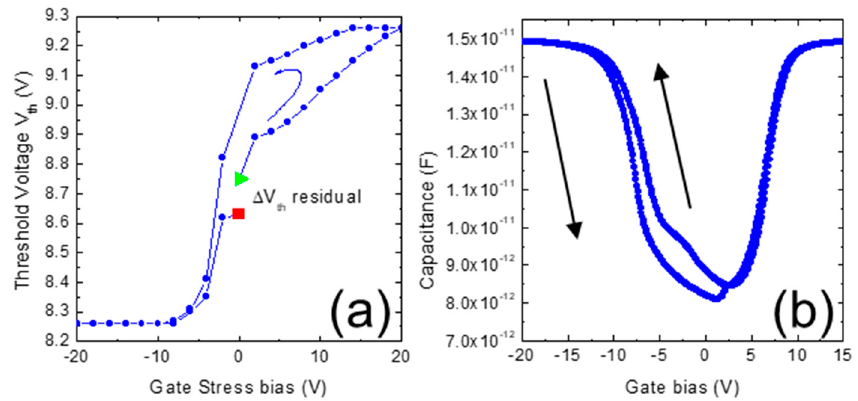
Figure 10. ( a ) Threshold voltage ( V th ) variation measured in a lateral 4H-SiC MOSFET after a gate stress bias loop. The arrow indicates the direction of the applied stress bias loop. ( b ) Inversion-to-accumulation and backward 1 kHz C–V s of MOSFETs in gate-controlled diode configuration. The figure is adapted from References [52,68].